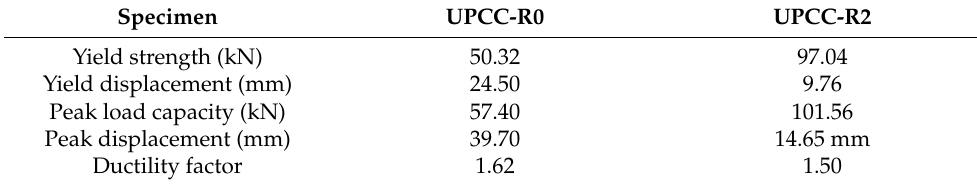
Figure 11. Comparison of hysteresis curves of two types of bridge piers. Table 5. Performance turning point of skeleton curve.